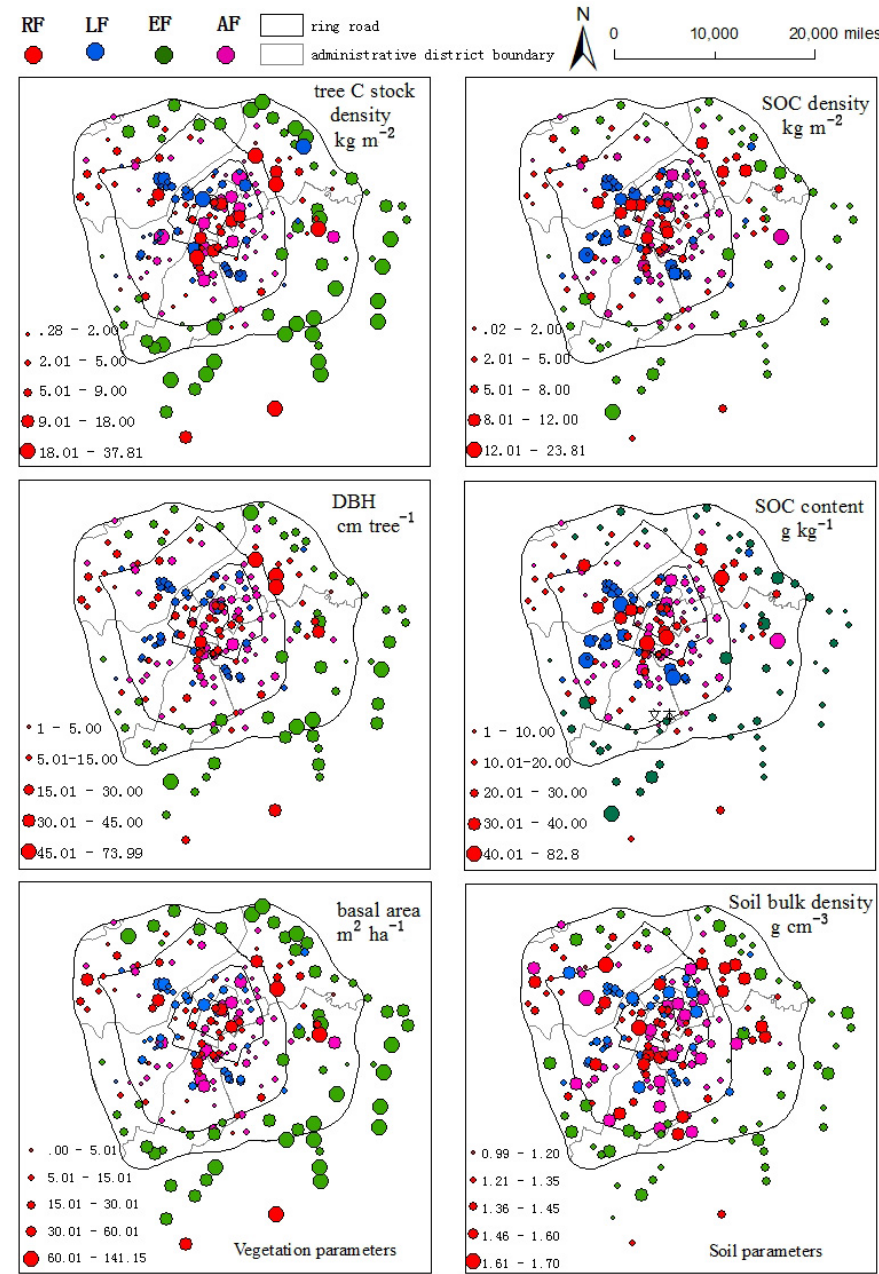
Figure 6. Variation in the spatial distribution of urban forest in Harbin City with respect to tree C stock density, basal area, and diameter at breast height (DBH) ( left ), plus variation in the spatial distribution of soil organic carbon (SOC) density, SOC content, and soil bulk density ( right ). Note: AF, affiliated forest; RF, roadside forest; LF, landscape and relaxation forest; EF, ecological public welfare forest. Label colors represent urban forest types, while label size represents the value range of each parameter.